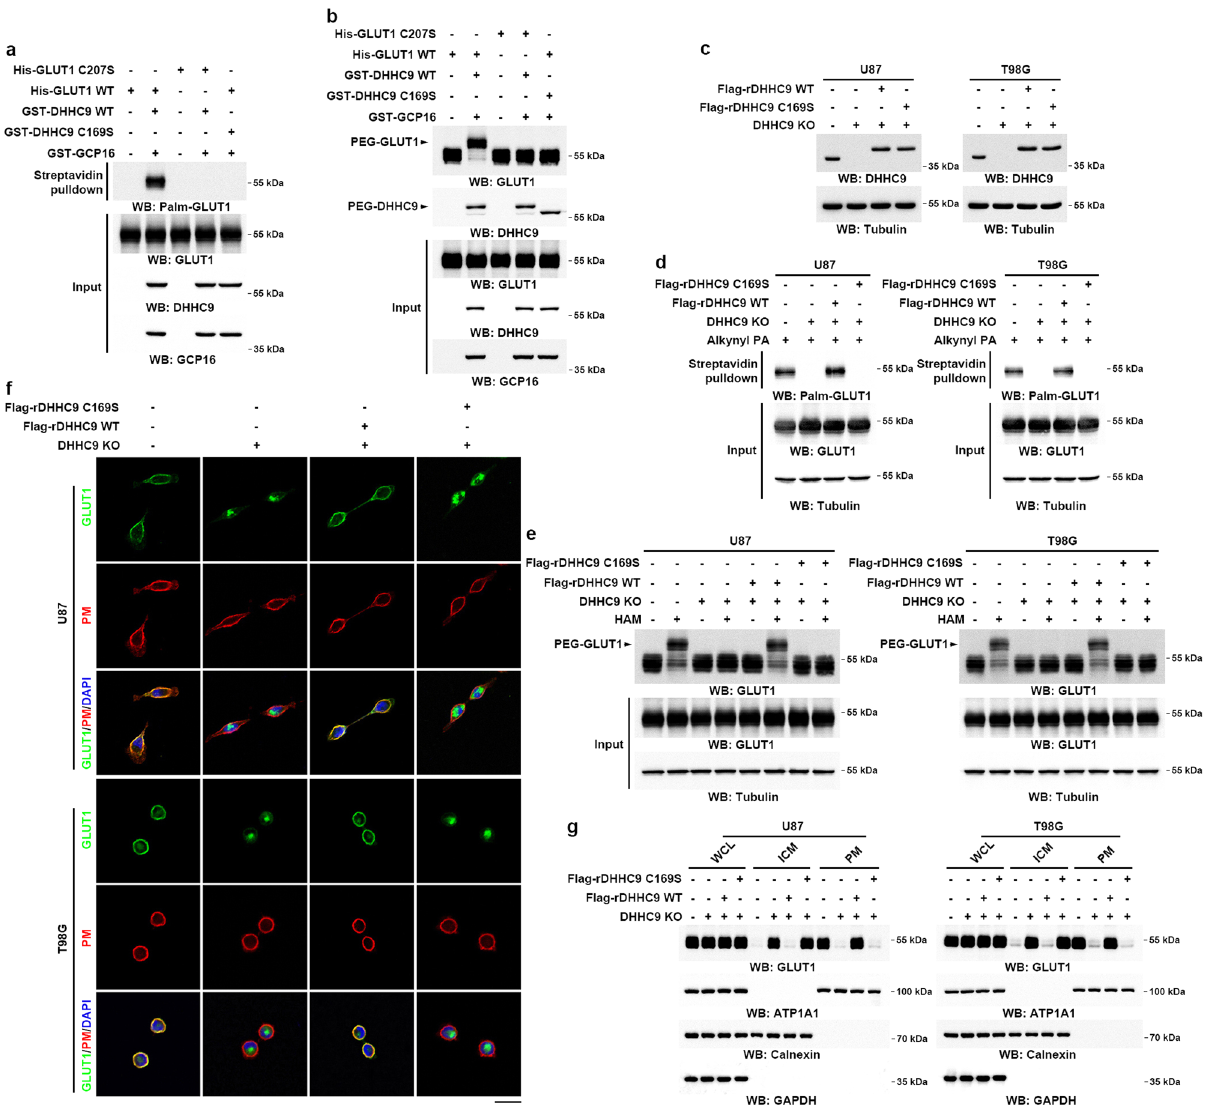
Fig. 3 DHHC9 palmitoylates GLUT1 at Cys207 to maintain GLUT1 PM localization. a In vitro palmitoylation analysis was performed by mixing puri fi ed WT DHHC9/GCP16 and DHHC9 C169S/GCP16 with puri fi ed WT GLUT1 or GLUT1 C207S in the presence of palmitoyl alkyne-CoA. GLUT1 palmitoylation levels were analyzed by click reaction and streptavidin bead pulldown, followed by immunoblotting. b In vitro palmitoylation analysis was performed by mixing puri fi ed WT DHHC9/GCP16 and DHHC9 C169S/GCP16 with puri fi ed WT GLUT1 or GLUT1 C207S in the presence of palmitoyl-CoA. The